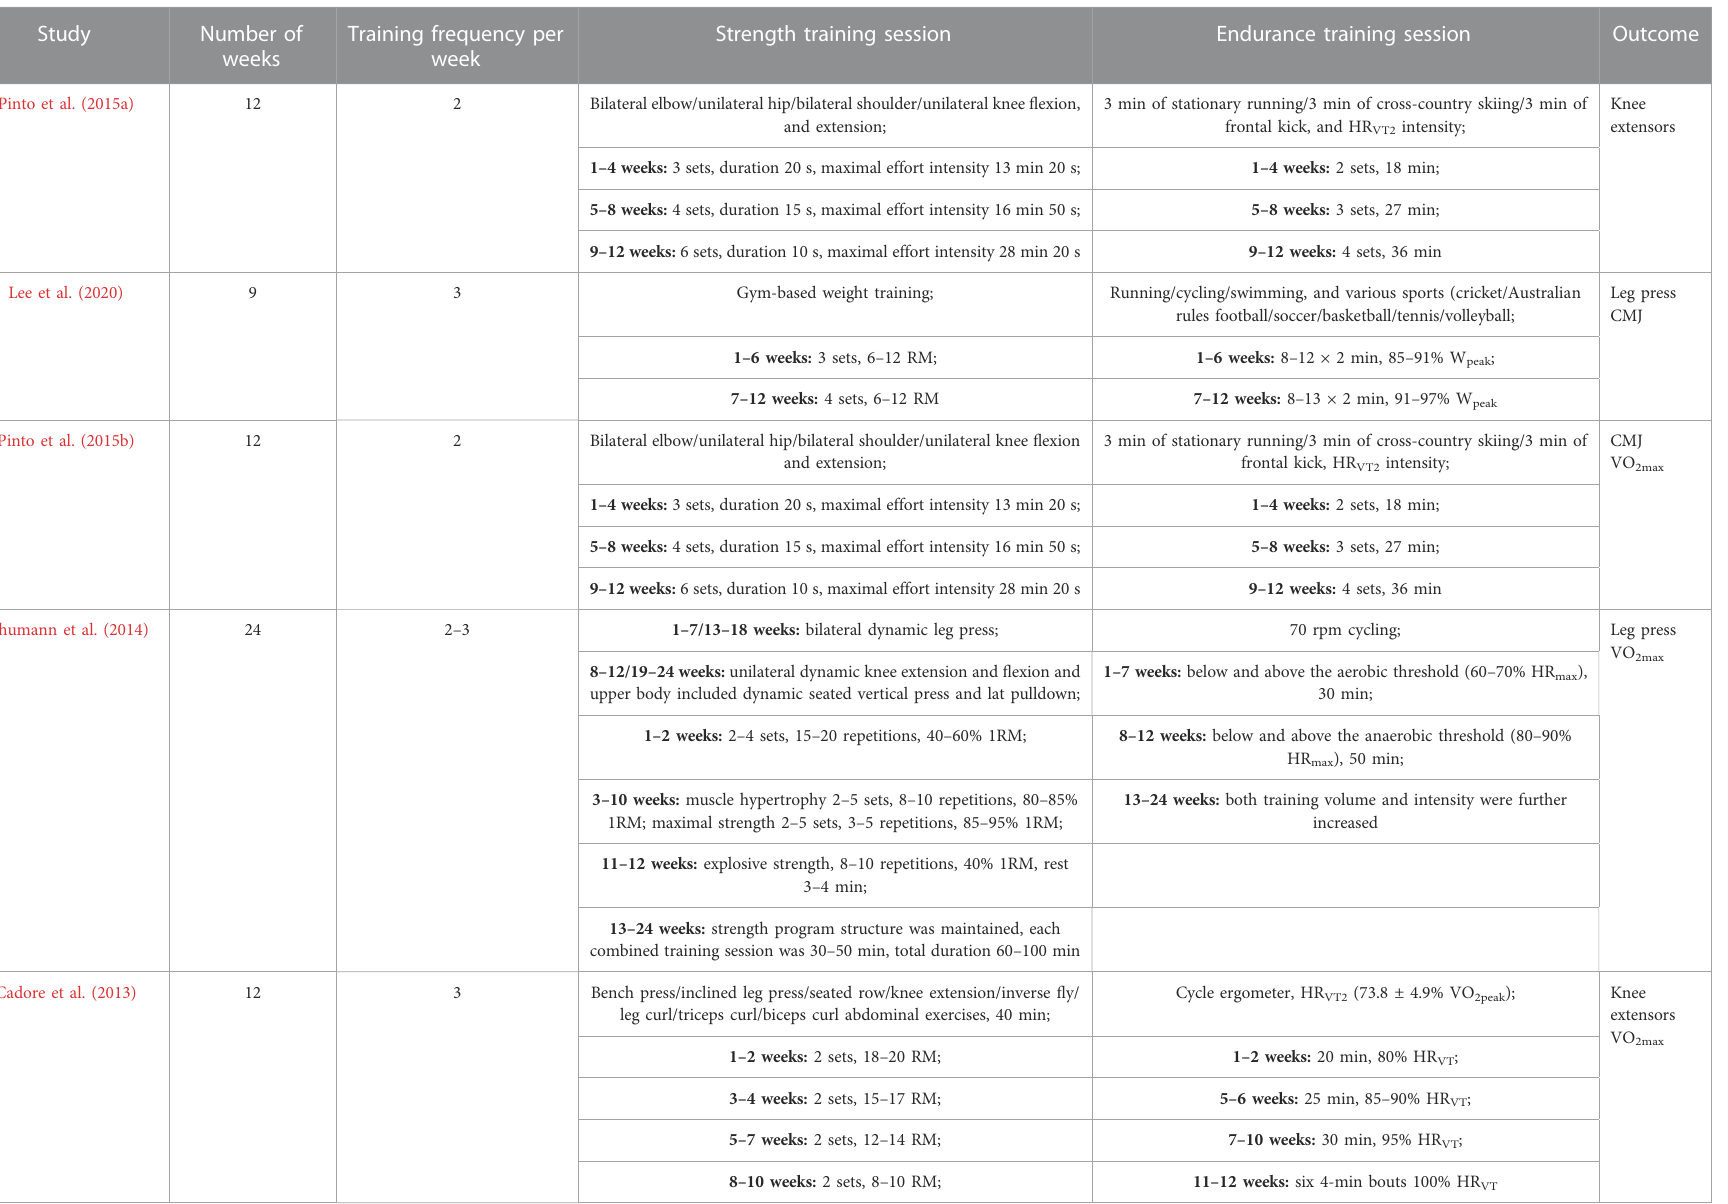
TABLE 2 Experimental protocols and outcomes of included